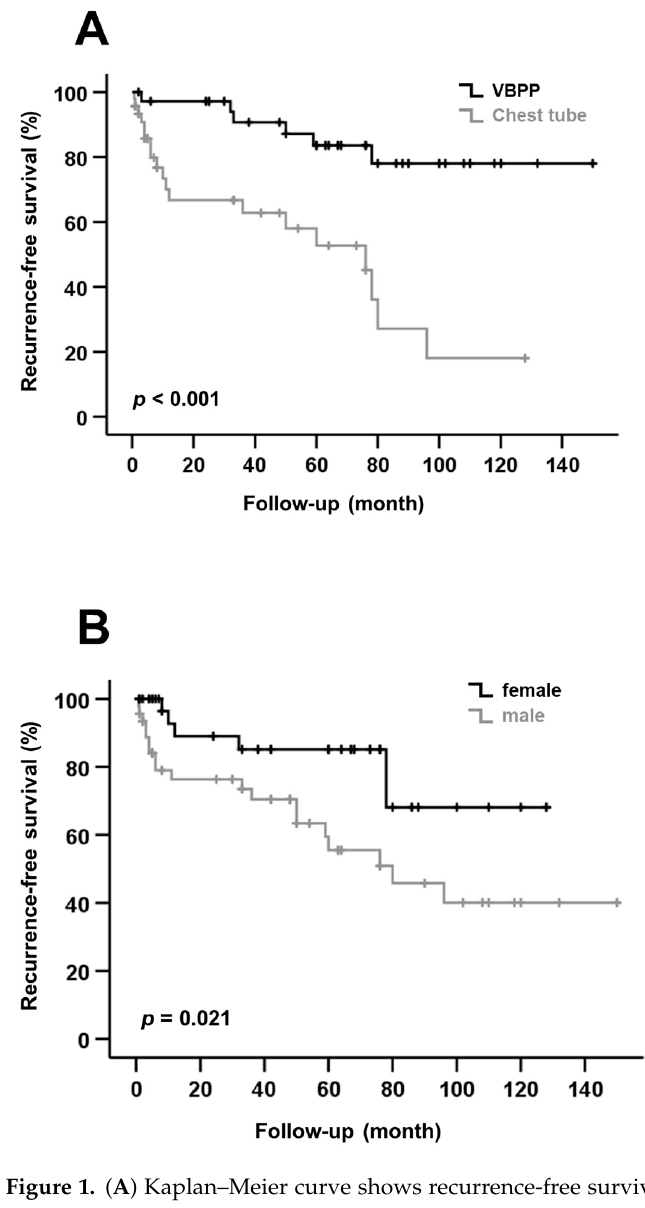
Figure 1. ( A ) Kaplan–Meier curve shows recurrence-free survival (RFS) after treatment by VATS- bullectomy with partial pleurectomy (VBPP) or chest tube (CT). VBPP was associated with significantly better RFS compared to CT treatment. ( B ) Male sex was associated with a significantly shorter RFS compared with female sex. Table 4. Multivariate Cox regression analysis of potential risk factors for recurrence of SSP.